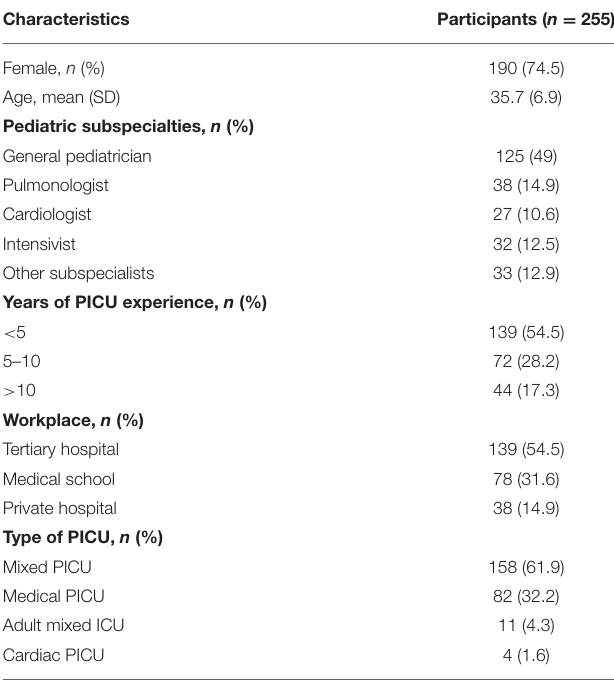
TABLE 3 | Demographic data and baseline characteristics of